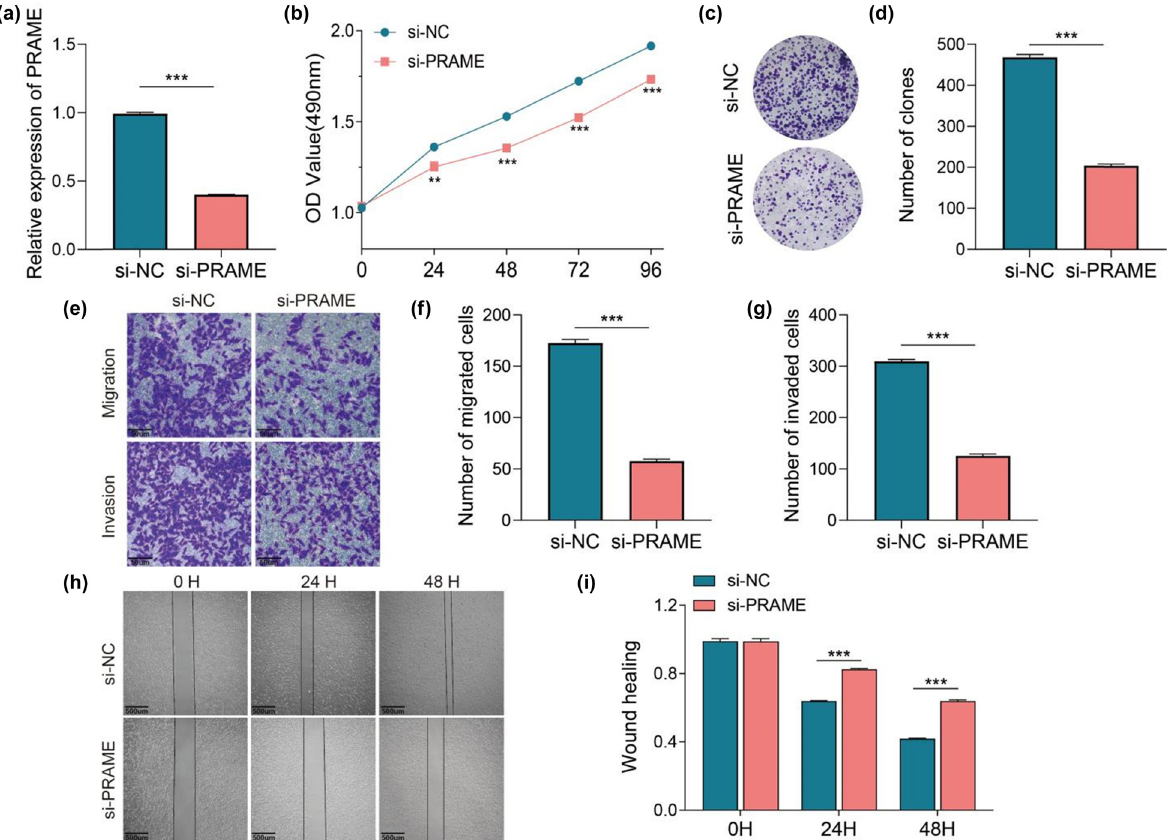
Figure A1: Downregulation of PRAME inhibits cell proliferation, migration and invasion in vitro . ( a ) The relative expression of PRAME signi fi cantly reduced after the cells were transfected with siRNA. ( b ) The cell viability was assessed via MTS assay after transfected with PRAME siRNA. ( c and d ) The colony formation capabilities were obviously decreased after PRAME was knocked down. ( e – g ) Decreased expression of PRAME attenuates the migratory and invasive capabilities by transwell assays. ( h and i ) The suppressed migration capability in cells treated with si - PRAME was demonstrated using wound healing assay . ( * p < 0.05, ** p < 0.01, *** p < 0.001 )